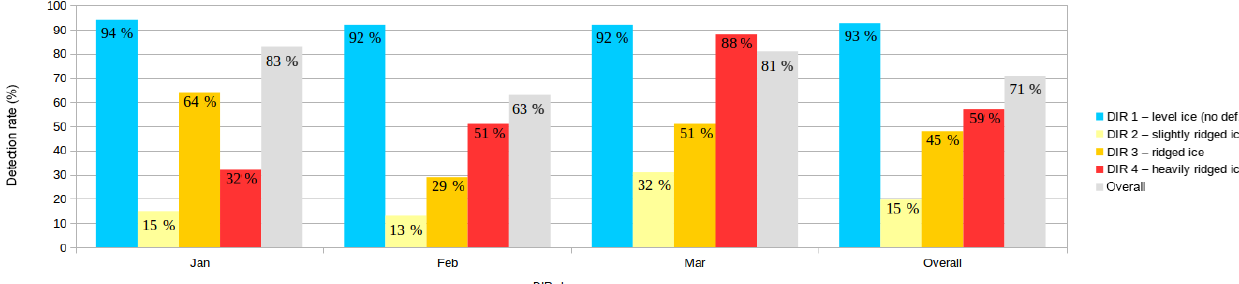
Figure 9. The detection rates for the different DIR categories in all the classification.